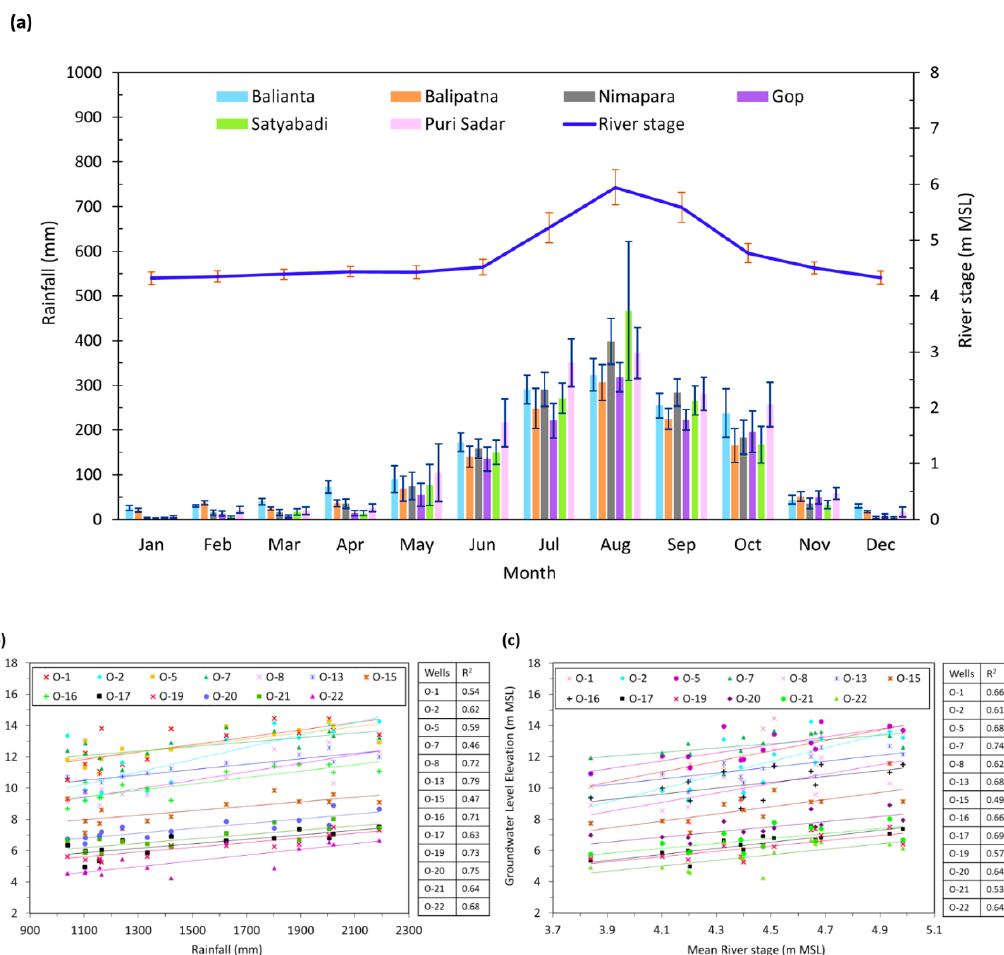
Figure 4. (a) Monthly rainfall and river stage patterns in the study area (adapted from [62); and Figure 4. ( a ) Monthly rainfall and river stage patterns in the study area (adapted from [62]); and regression analyses (b) between rainfall and groundwater levels at 13 sites (observation wells) of regression analyses ( b ) between rainfall and groundwater levels at 13 sites (observation wells) of Aquifer-1, and ( c ) between river stage and groundwater Aquifer-1, and (c) between river stage and groundwater levels.